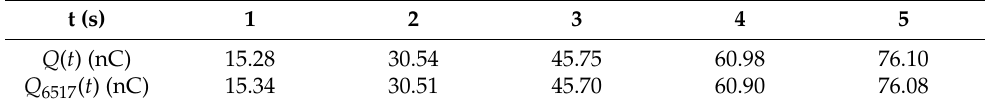
Table 2. Accumulated charge over